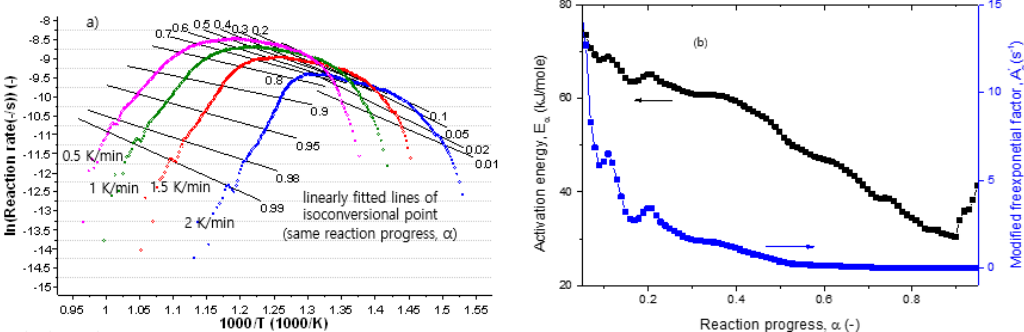
Figure 5. Plots for the determination of the activation energy E α ( a ) and the determined modified pre-exponential factor A ′ ( α ) (=A α f ( α )) for reaction step R3 ( b ).